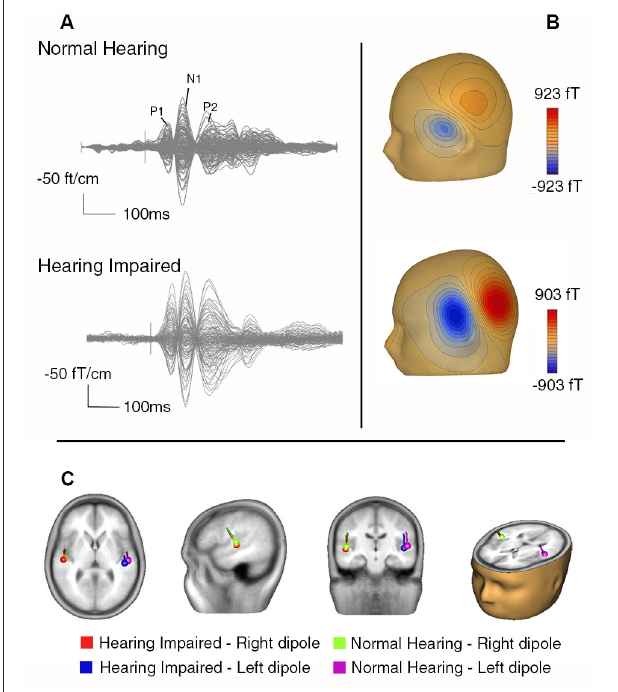
FIGURE 4 | (A) Butterfly plot showing AEFs from a representative normal hearing older adult (top) and a hearing impaired older adult (bottom) averaged over all stimulus types from all sensors. (B) The contour maps for the N1m for these two participants indicate the direction of the magnetic flux (i.e., blue = negative, red = positive). (C) The group mean dipole location for the N1m from the normal and hearing impaired older adults overlaid on a magnetic resonance imaging template from BESA